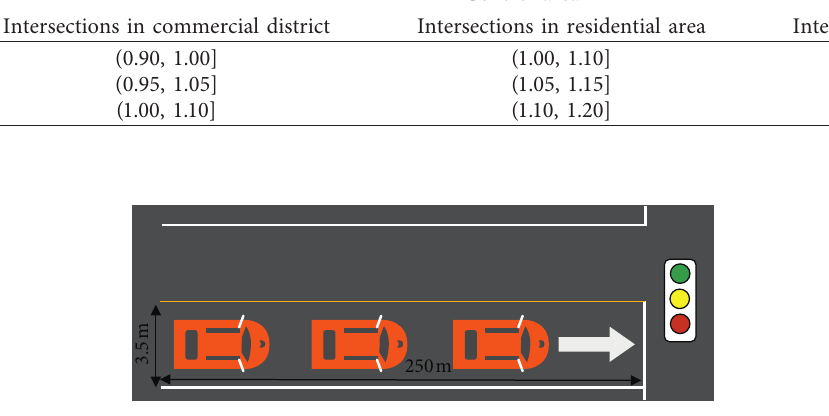
Figure 6: Geometric layout of an arm in the numerical case. Table 5: Parameters in numerical case study.